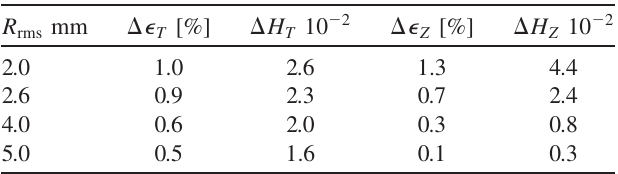
TABLE IV. Space-charge dependence—Gaussian beam, v ¼ 0 .